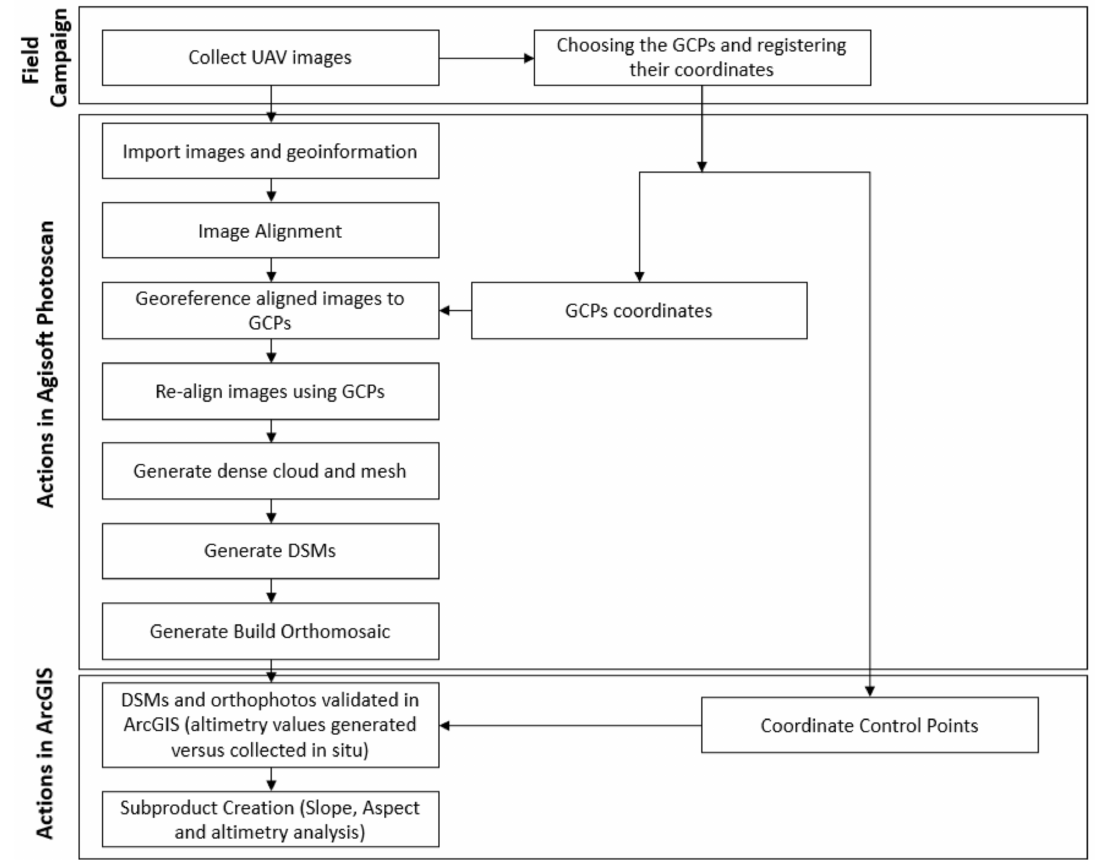
Figure 3. Procedures for DEM generation (adopted from